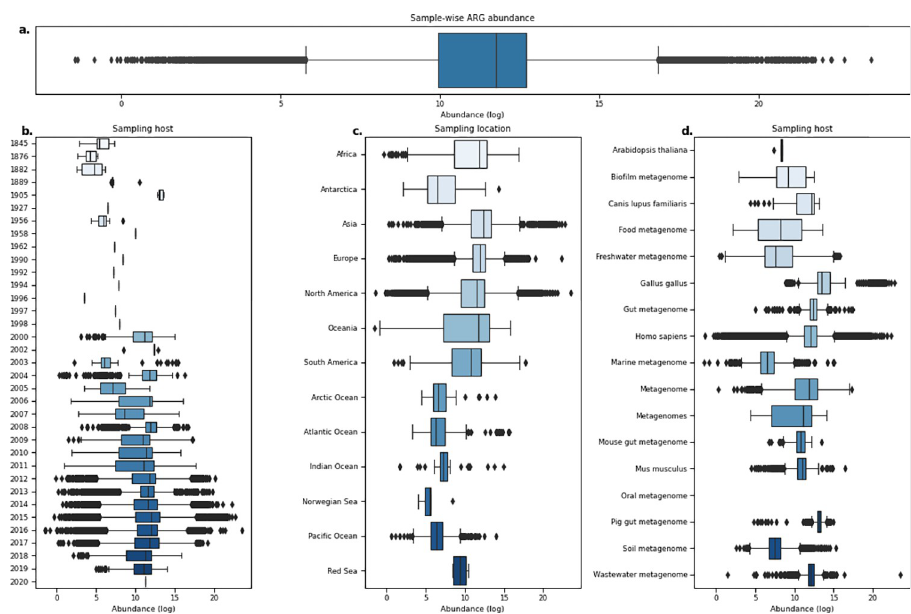
Fig 3. Boxplots of ARG abundances in metagenomic samples show that levels vary across different origins. (a) Distribution of ARG abundance per sample . (b) Distribution of sample-wise ARG abundance grouped by sampling year. (c) Sample-wise ARG abundance per sampling location. (d) Sample-wise ARG abundance grouped by hosts. Only hosts with more than 1,000 metagenomes analyzed are shown. The data underlying this figure can be found